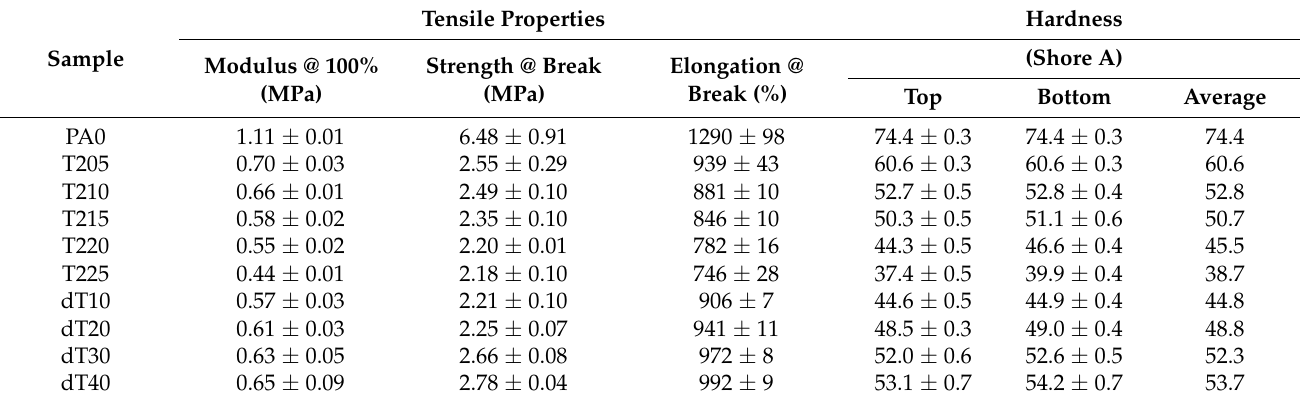
Table 3. Tensile and hardness results for unfoamed, uniform and graded POE